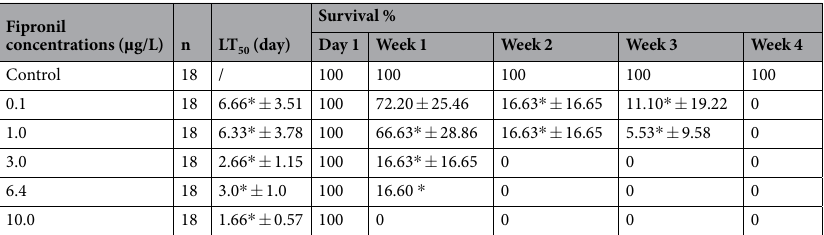
Table 2. Weekly survival rate (mean ± standard deviation) of juvenile shrimp starting from day1 to the end of the experiment. n = number of shrimp individuals in each treatment (6 shrimp per replicate aquarium, 3 aquariums per treatment). LT 50 is the time required for 50% of shrimp to die after the exposure to fipronil under each treatment, measured per day in this study. Values with star ( * ) indicate treatment is significantly different from the control (P <